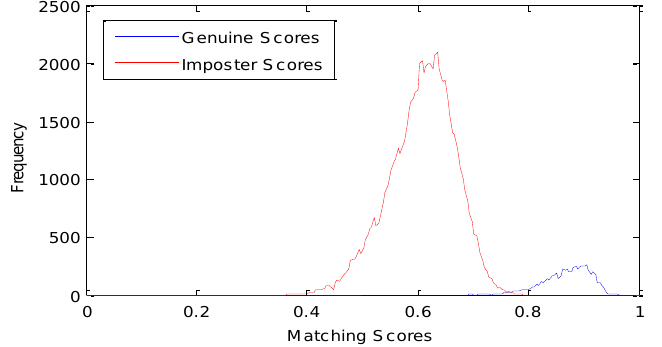
Figure 8. Genuine and imposter matching score distributions by PWM.